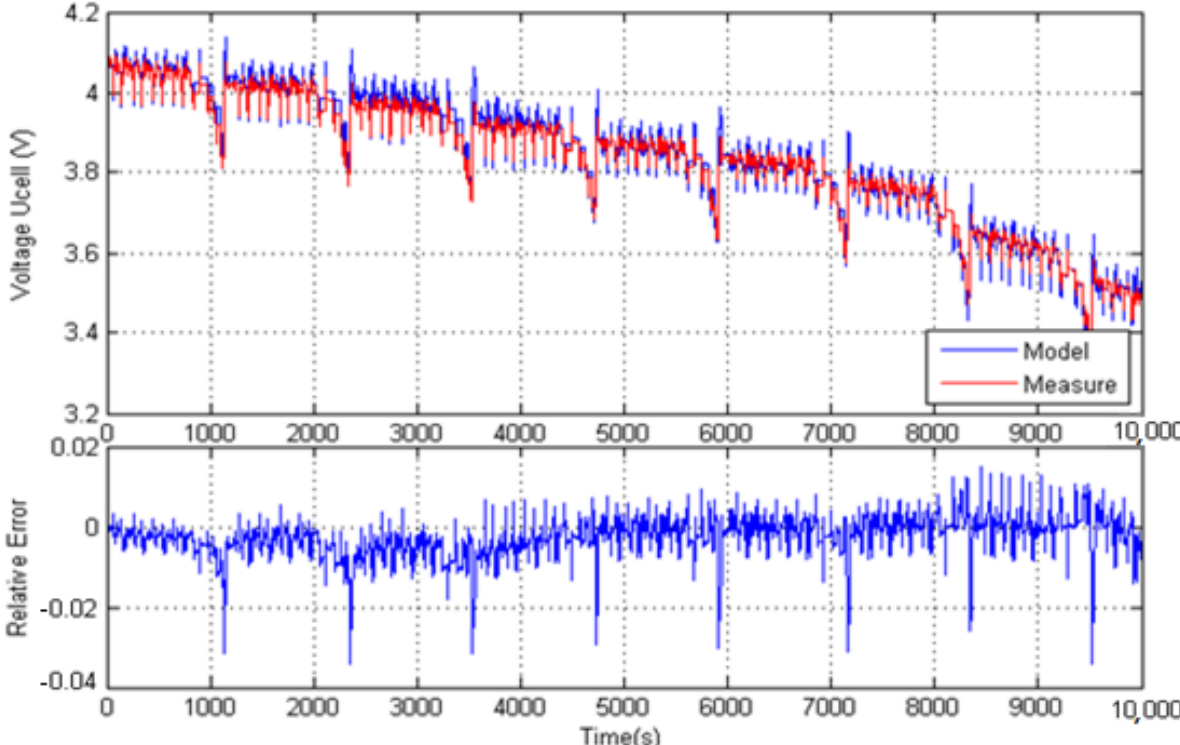
Figure 13. Comparison between measurement and Thevenin model prediction.